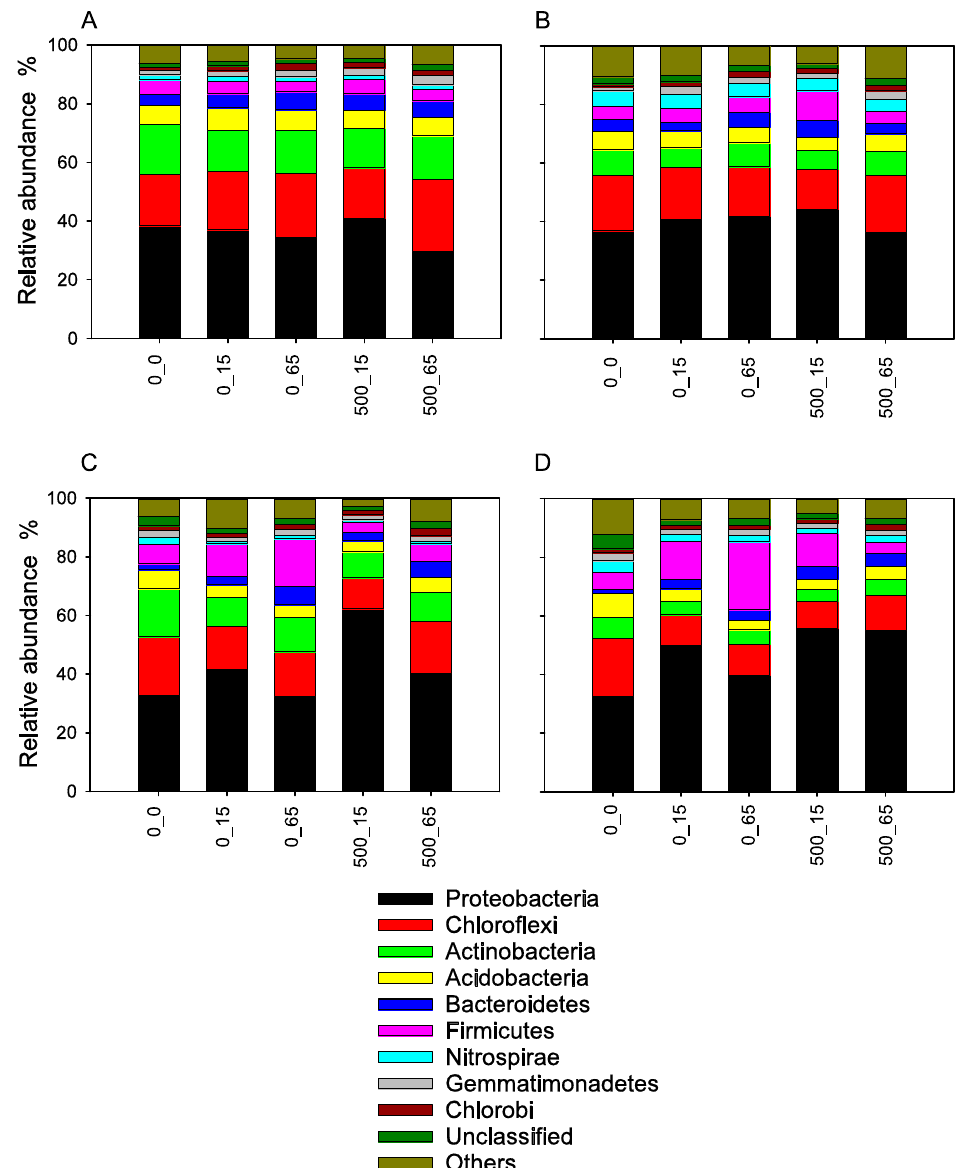
Figure 5. Mean relative abundance of major bacterial phyla (>1% relative abundance) on 16S rRNA gene ( A , C ) and 16S rRNA ( B , D ) level for surface ( A , B ) and subsurface ( C , D ) sediment samples. Phyla accounting for less than 1% of all sequences are grouped as “others”. Sample code: 0, 500 indicate supplemental TrOC concentrations in µg L − 1 . 0, 15, 65 represent sampling days.